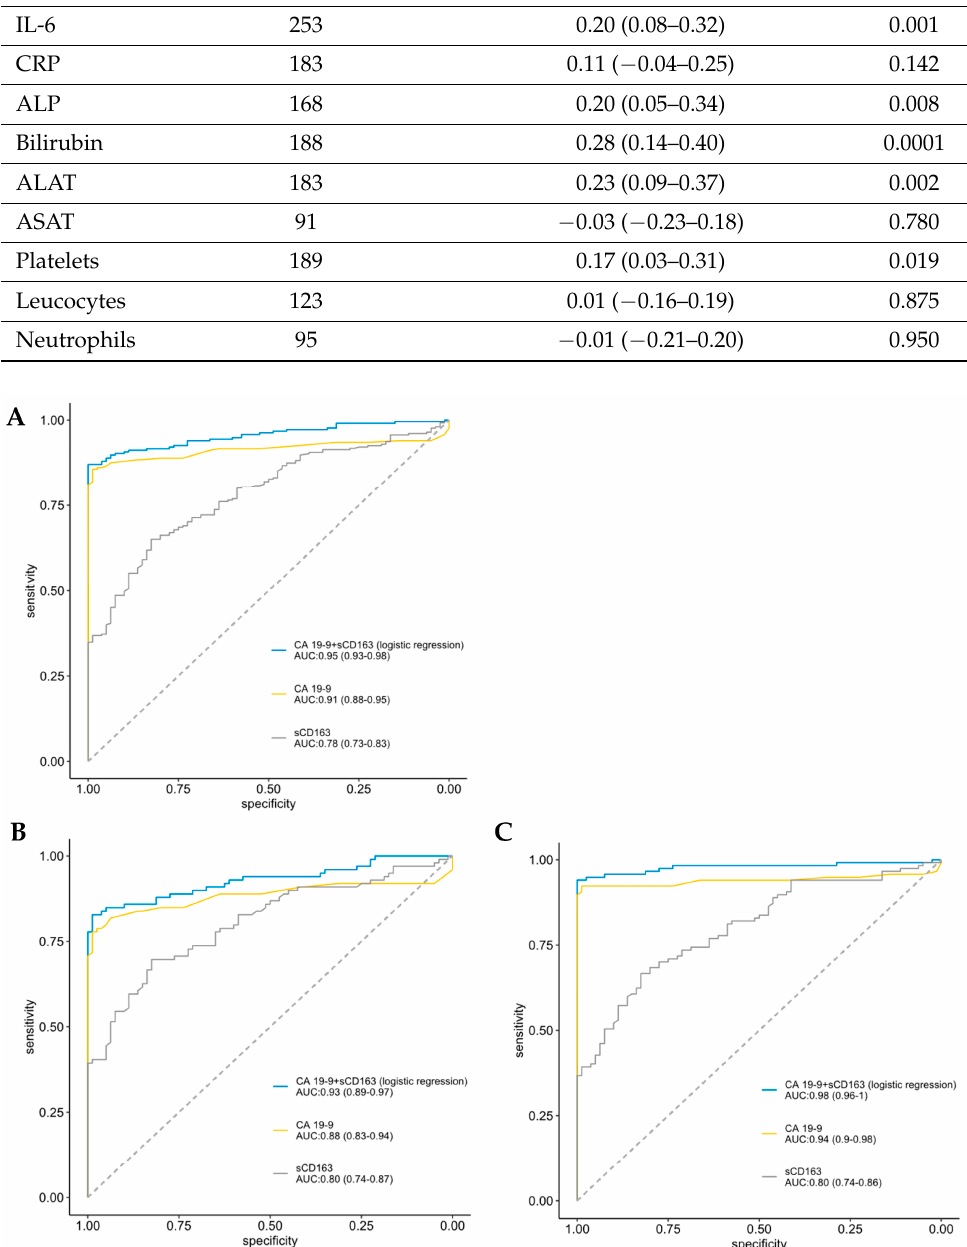
Figure 2. ROC curves for single sCD163, single CA19-9 and the combination of them in discriminating all patients ( A ), resected patients ( B ), and patients with locally advanced and metastatic pancreatic ductal adenocarcinoma ( C ) from healthy